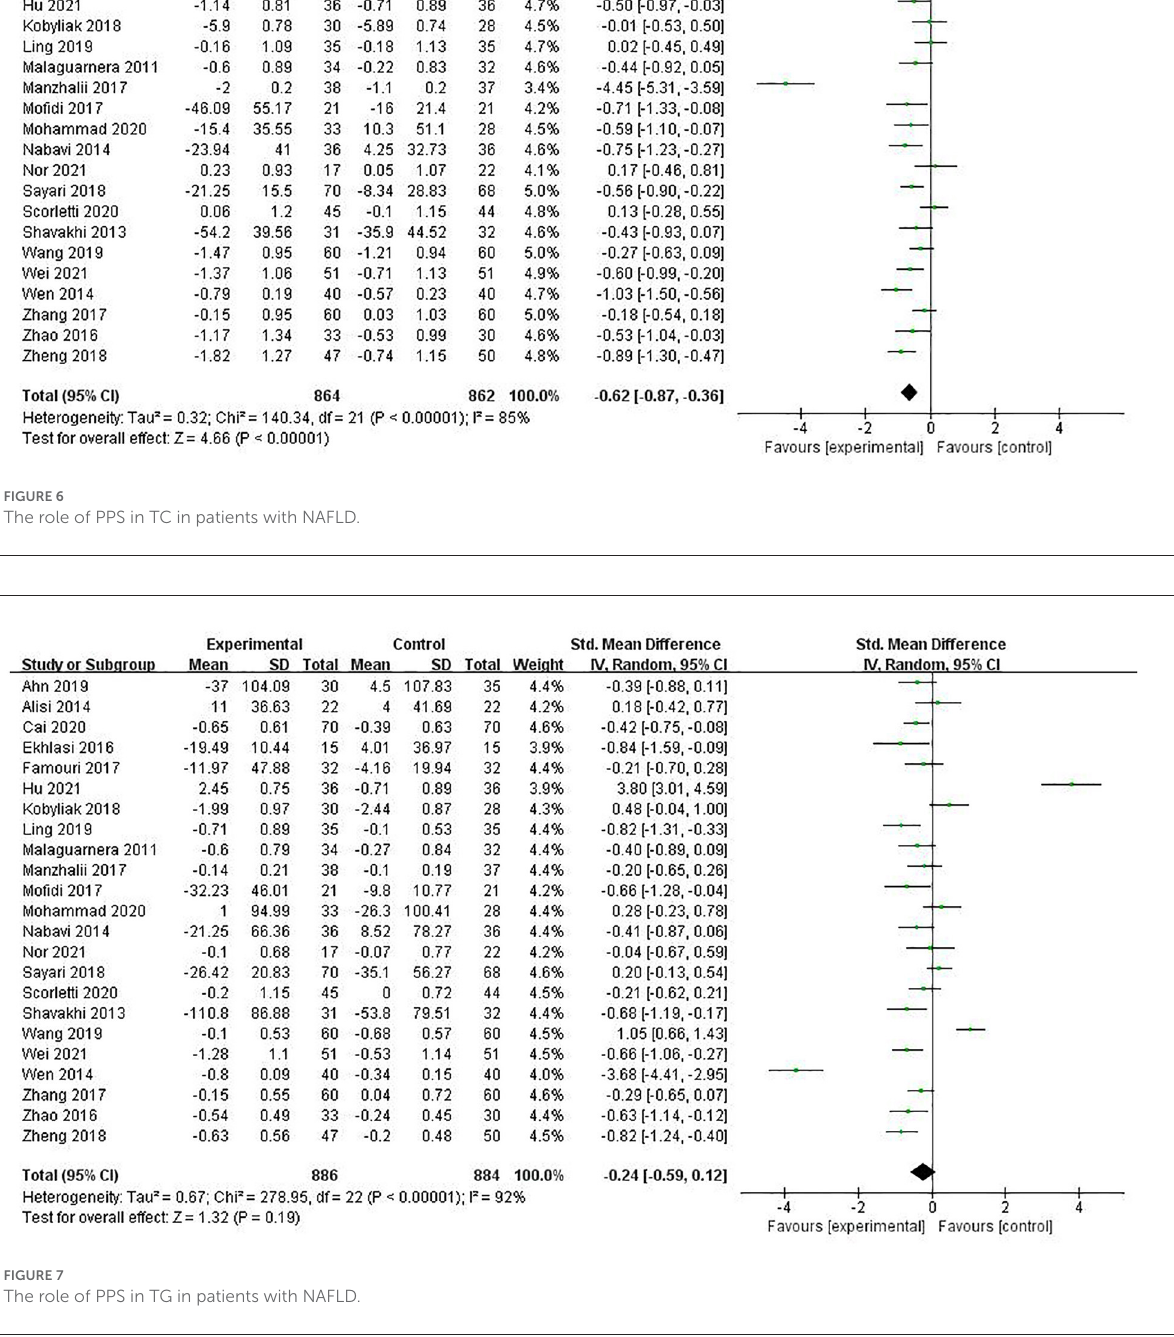
insulin in NAFLD patients, and thus play a certain role in regulating the sugar metabolism level of patients. In 70–80%